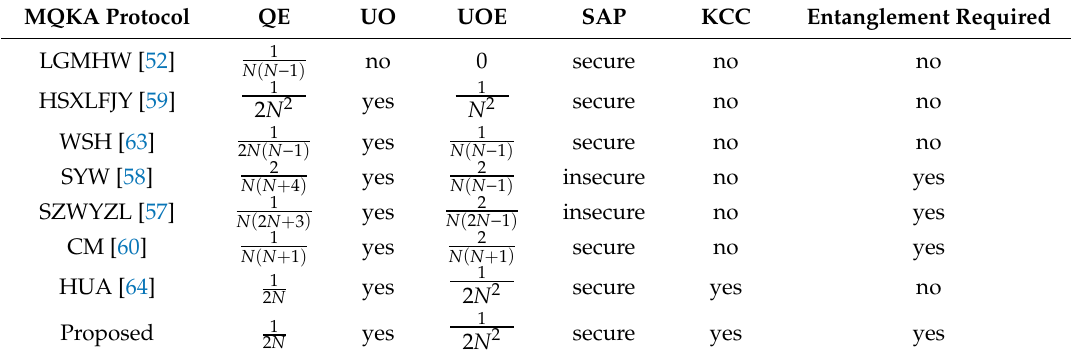
Table 8. Comparative analysis of multiparty QKA (MQKA)